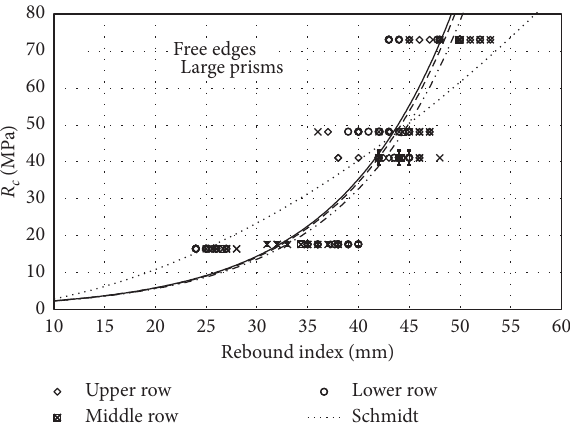
Figure 5: Calibration curve for different distances of the test lo- cation from free edges. Dash-dotted line: in the middle of the element; continuous and dashed line: close to the free edges; dotted bold line: Schmidt curve. Calibration curve: R c � e a RI ; RI � rebound index; a ∈ [0.87, 0.89]; R 2 ∈ [0.66, 0.84]. Inside any dataset, C.o.V. ≤